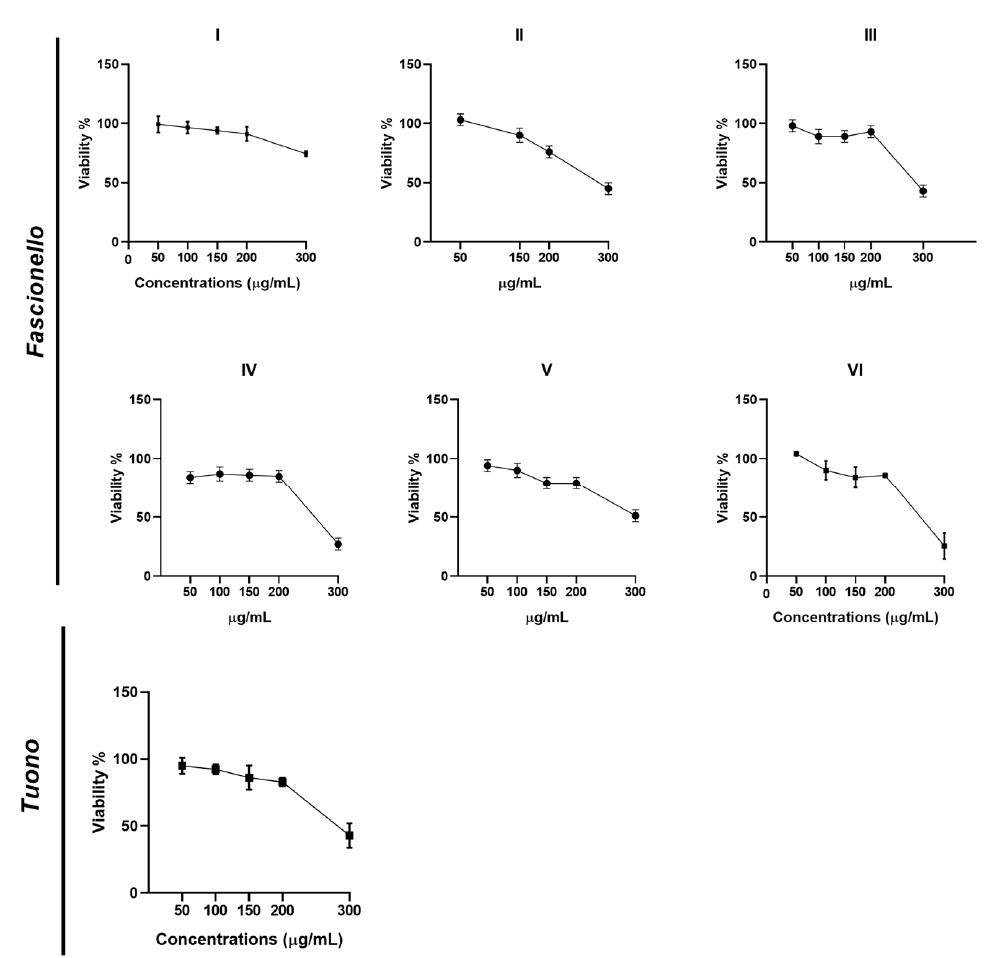
Figure 6. Viability assay of Vero cells treated with BSE from Fascionello and Tuono cultivars. Vero cells were treated with different concentrations of BSE (50 µ g/mL, 100 µ g/mL, 150 µ g/mL, 200 µ g/mL, and 300 µ g/mL). The cells were collected 72 h post-treatment. The cell viability was carried out as described in the Materials and Methods section and graphically reported as a percentage of viability (%). The assay was performed as means of triplicates ± SD. I to VI represent different producers. Table 6. Selectivity index (SI), cytotoxicity (CC 50 ), and antiviral activity (EC 50 ) of blanched skin extracts (BSE).